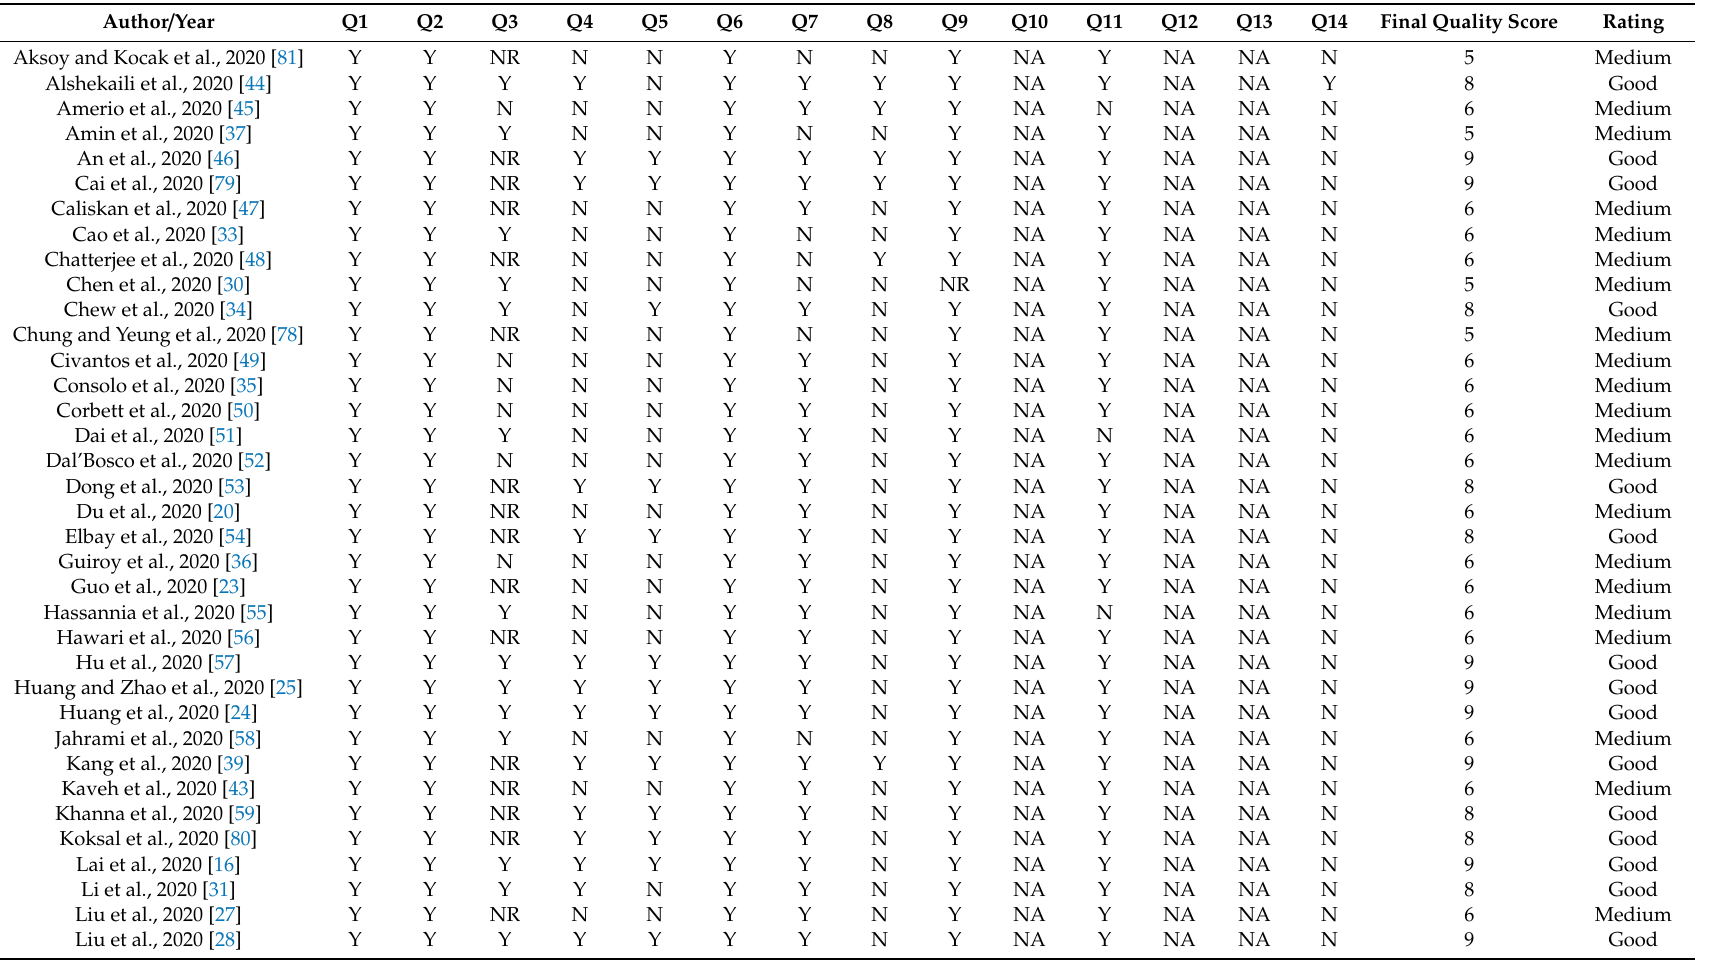
Table A2. Methodological quality assessment of included studies using the National Institutes of Health (NIH)